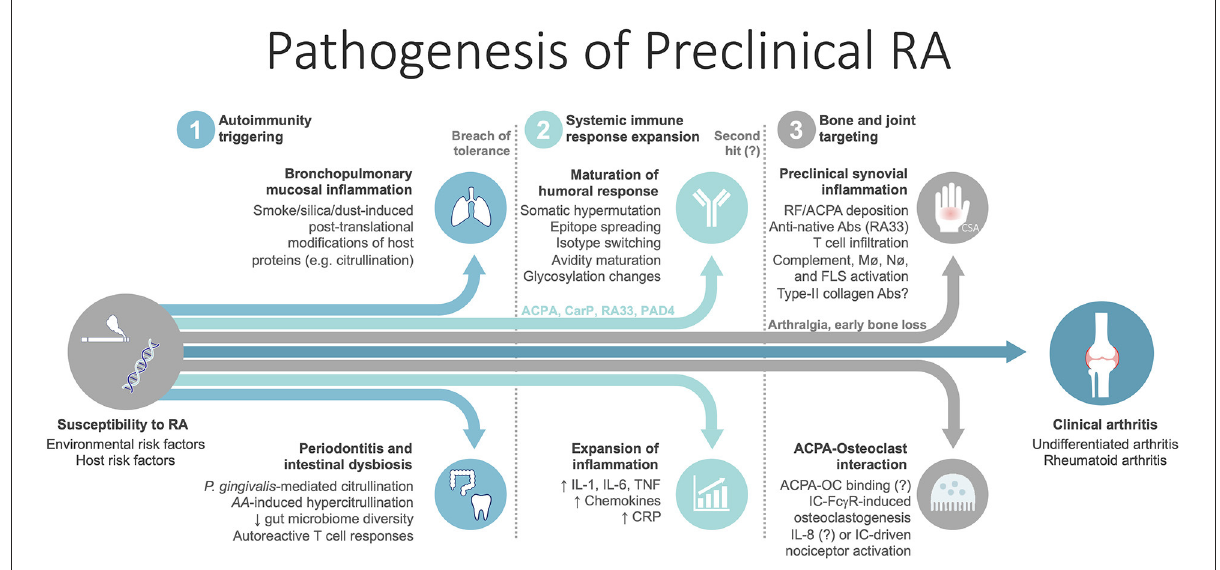
FIGURE1 Summary of the pathogenic steps unfolding in the preclinical phase of rheumatoid arthritis. Mechanisms for which evidence is conflicting and significant uncertainty remains are followed by a question mark. AA , Aggregatibacter actinomycetemcomitans ; Abs, antibodies; ACPA, anti-citrullinated protein antibodies; CarP, carbamylated protein; CSA, clinically suspect arthralgia; FLS, fibroblast-like synoviocytes; IC, immune complexes; Mø, macrophages; Nø, neutrophils; OC, osteoclast; P. Gingivalis , Porphyromonas gingivalis . PAD4, peptidyl-arginine deiminase 4; RA33, heterogeneous nuclear ribonucleoprotein (hnRNP)-A2, also known as RA33; RF, rheumatoid